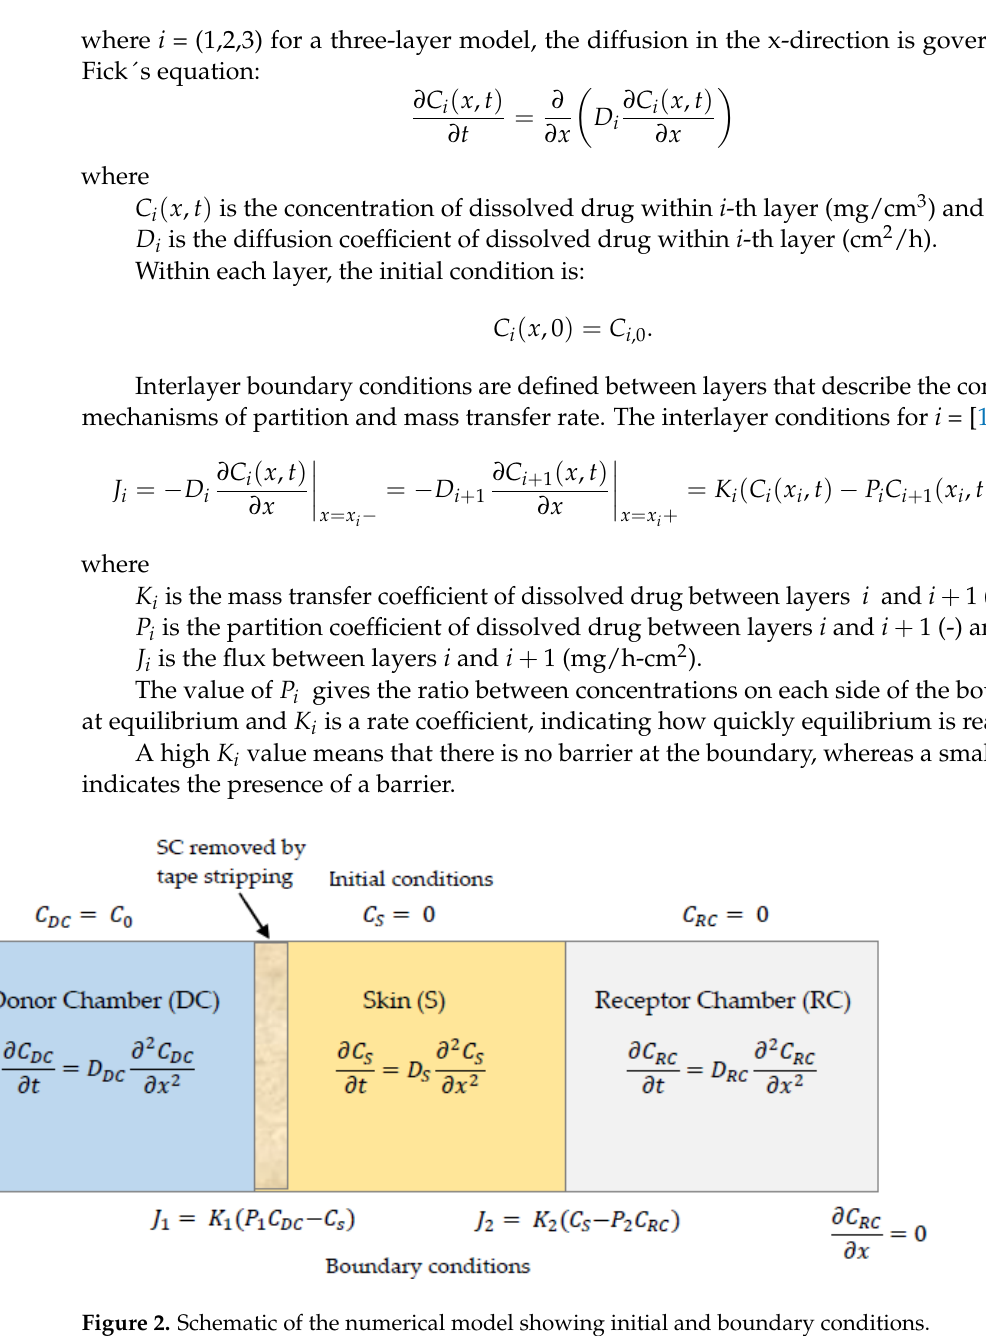
the concentration of drug in the SC layer of the skin matches the tape stripping results. That is, P 1 is estimated from the ratio of the concentration in the SC layer of the skin and the concentration in the DC. After obtaining a value for P 1 , the other parameters P 2 , K 1 , and K 2 are obtained by matching the RC experimental results as closely as possible. The diffusion coefficient in the skin is determined experimentally by using the lag time method [31]. distribution of the